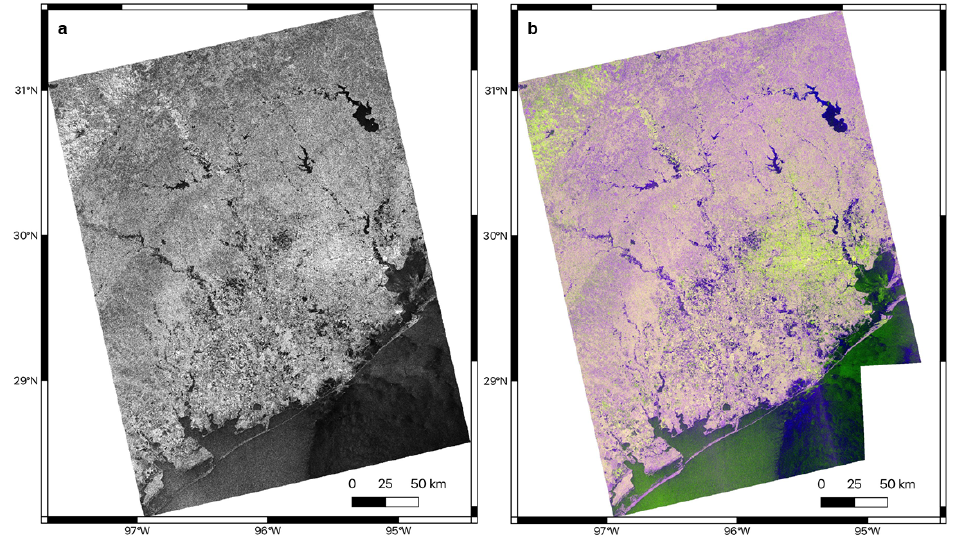
Figure 5. ( a ) Sentinel-1 SAR image, 29 August 2017, 10 m pixel spacing; ( b ) false color RGB image, where VH is blue, VV is green, and VH/VV is blue, 10 m pixel spacing.